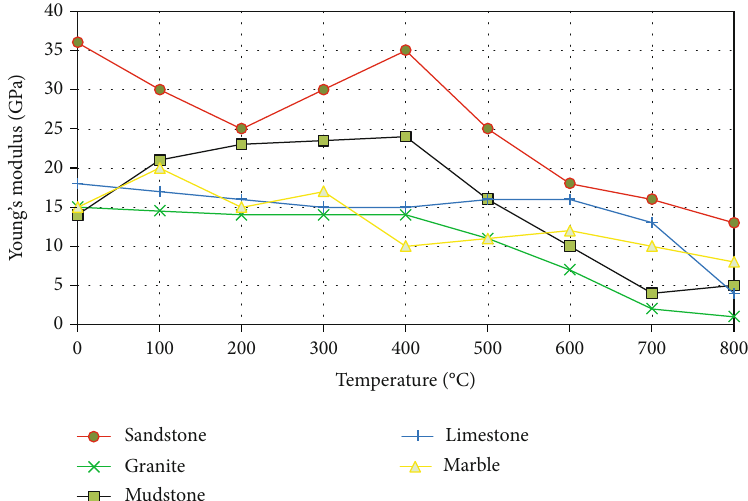
Figure 4: Water viscosity at di ff erent temperatures.